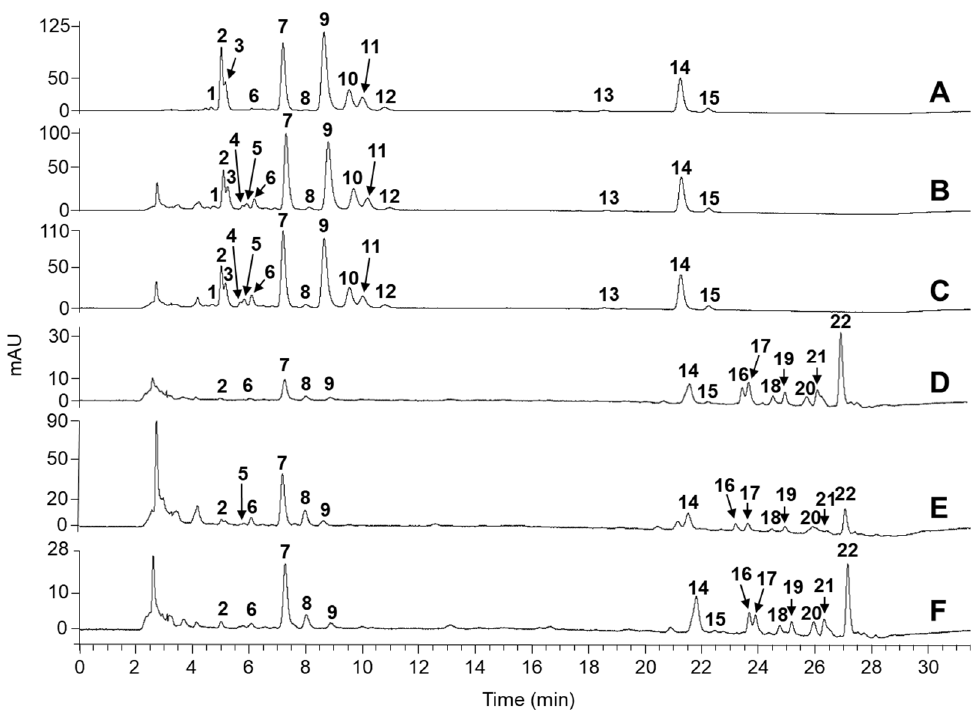
Figure 2. Separation of carotenoids extracted from spinach leaves ( A ), green leaves of Bohemian knotweed ( B ), green leaves of Japanese knotweed ( C ), yellow leaves of Japanese knotweed ( D ), greenyellowish leaves of Japanese knotweed ( E ), and yellow leaves of Bohemian knotweed ( F ): Violaxanthin ( cis or trans ) ( 1 , 2 ), neoxanthin ( 3 ), luteoxanthin ( cis or trans ) ( 4 , 5 ), antheraxanthin ( 6 ), (all- trans )-lutein ( 7 ), (all- trans )-zeaxanthin ( 8 ), chlorophyll b ( 9 ), chlorophyll a ( 10 ), chlorophyll b’ ( 11 ), chlorophyll a’ ( 12 ), (13- cis )- β -carotene ( 13 ), (all- trans )- β -carotene ( 14 ), (9- cis )- β -carotene ( 15 ), violaxanthin palmitate oleate ( 16 ), antheraxanthin dilaurate ( 17 ), luteoxanthin dimyristate ( 18 ), luteoxanthin palmitate oleate ( 19 ), zeinoxanthin palmitate oleate or β -cryptoxanthin palmitate oleate ( 20 ), violaxanthin palmitate stearate ( 21 ), violaxanthin myristate ( 22 ).